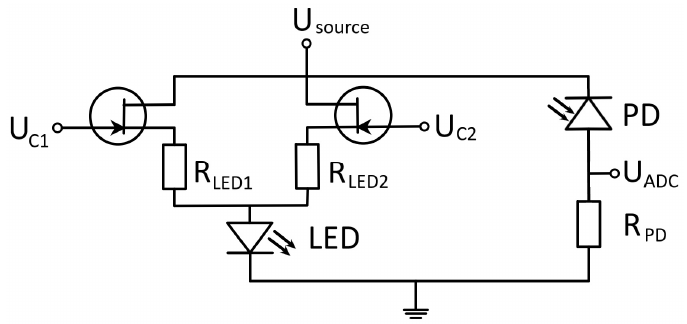
Figure 3. Schematic of electronic chain of the sensor. LED—light emitting diode, PD—photodiode, U source —source voltage, U c1 and U c2 —control voltages for LED power supply control, U adc —ADC input voltage, R led1 , R led2 , and R pd —load resistors.